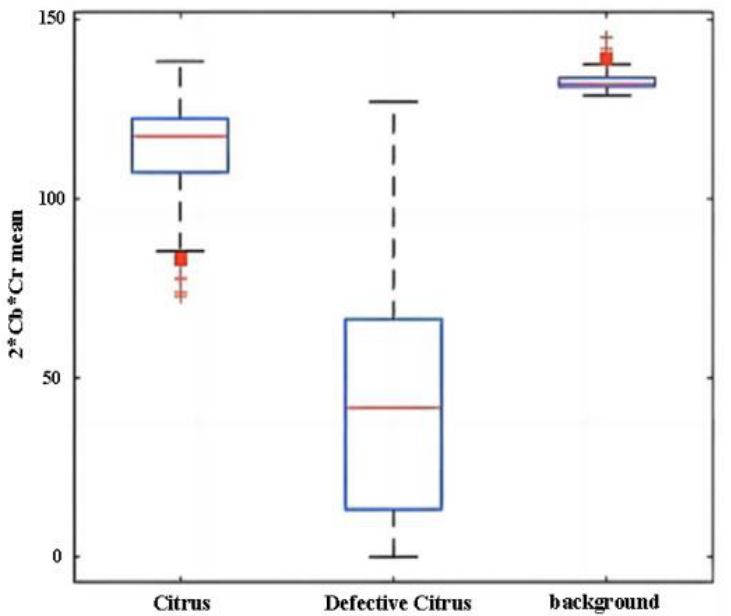
Figure 7. Boxplot of 2*Cb-Cr feature mean. The three red lines of the three blue boxes in the figure are the median of the feature of citrus, defective citrus and background respectively. The two lines above and below the blue box represent the maximum and minimum values of the feature.